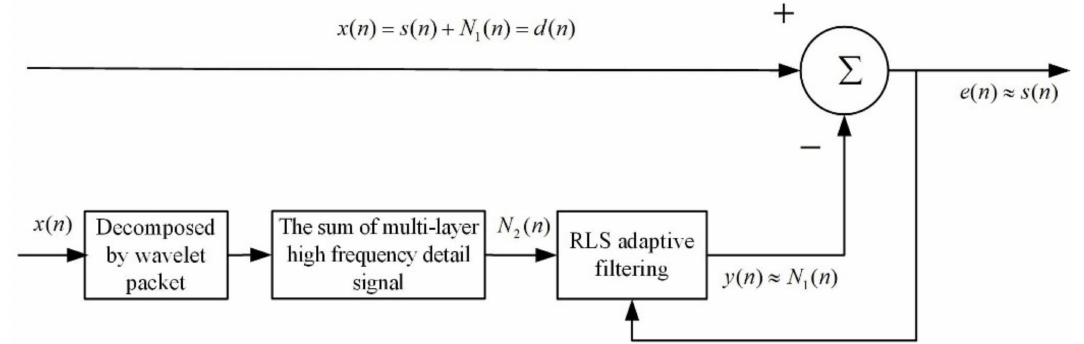
Figure 10. Noise reduction principle for a combination of the wavelet packet and the Recursive Least Squares (RLS) adaptive